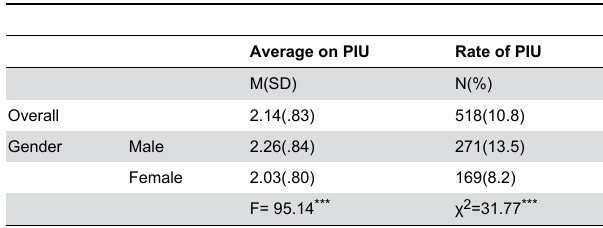
Table 2. Gender Differences of Perceived Parental Internet Use and Parent-adolescent